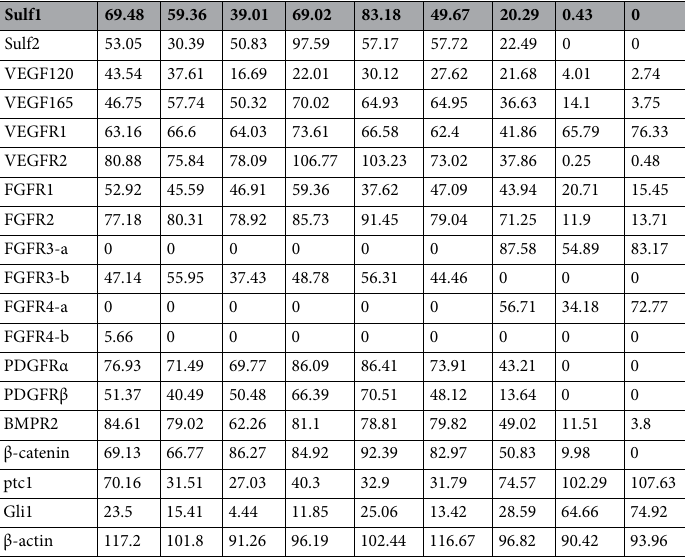
Table 1. This table related to Fig. 1. Levels of different mRNAs during different fetal developmental stages of human cardiovascular